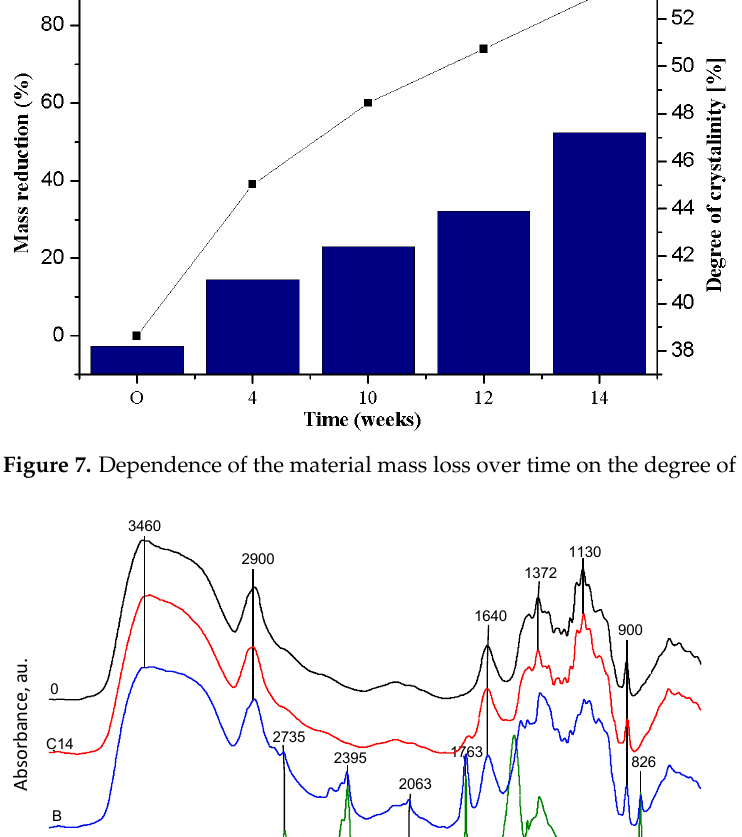
Figure 9. FT-Raman spectra in the range of 3700–500 cm − 1 for: 0—viscose nonwoven, B—KNO 3 - modified nonwoven and pure potassium nitrate crystals (KNO 3 ). The FT-Raman spectrum (Figure 10) for nonwoven C after 14 weeks of testing (sam- ple C14), on the other hand, presents the disappearance of the absorption bands charac- teristic for the original viscose spectrum (sample 0) in the area of 1460–900 cm − 1 [36,37]. On the C14 curve, there are two distinct absorption maxima at 1601 cm − 1 and 1305 cm − 1 . The appearance of these bands may be the result of changes in the viscose structure during the polysaccharide chain degradation process. Shortening the macromolecule chain pro- motes an increase in the ordering in the material, which in turn affects the shape and shifts of the emission bands in Raman spectra.